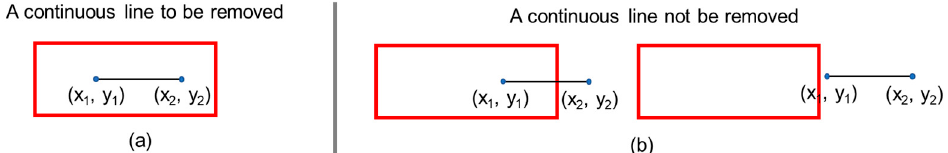
Figure 13. Removal of continuous lines corresponding to texts and symbols. ( a ) Both points of a continuous line are inside bounding boxes of symbols and texts. ( b ) Both points of a continuous line are not inside bounding boxes of symbols and